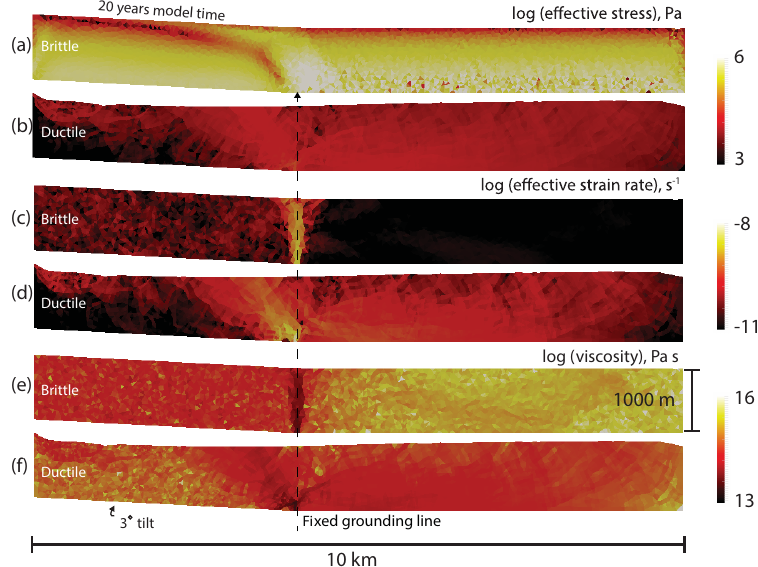
Figure 3. Comparisons of purely brittle (a, c, e) and purely ductile (b, d, f) tilted-slab experiments. (a, b) Effective stress, (c, d) effective strain rate, and (e, f) viscosity after 20 years of model time. Overall the brittle rheology results in a narrow process zone of high stress and deformation, while the ductile rheology has a more diffuse area of strain and lower